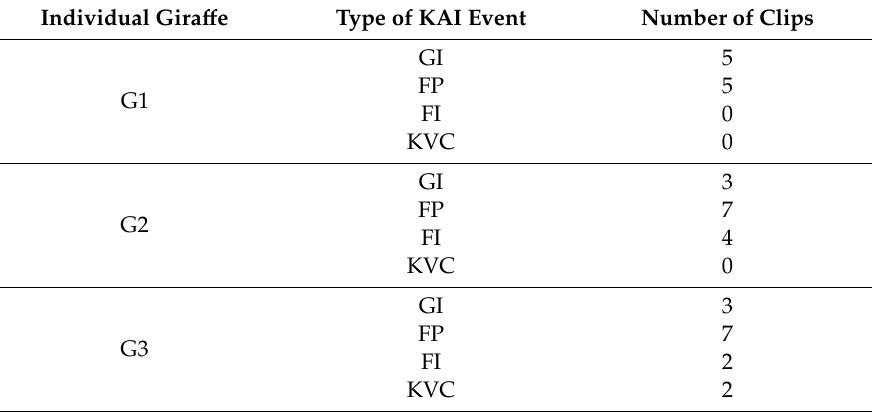
Table 2. Number of clips obtained for each gira ff e (gira ff e 1 = G1, gira ff e 2 = G2, gira ff e 3 = G3) and KAI event (where GI is Gira ff e Initiated, FP is food provision, FI is food incentive and KVC is keeper verbal call).